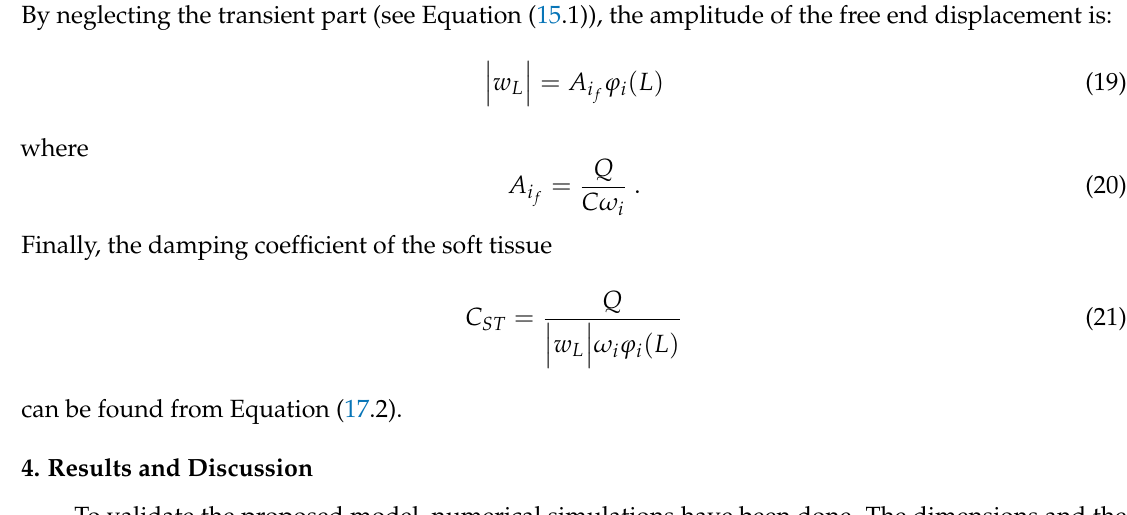
Table 1. Beams, piezoelectric plates and end masses specifications; lengths are expressed in µ m. Material Length Thickness Width Young’s mod. [GPa] Density [ kg / m 3 ] Beams Silicon 750 170 2329 Piezoel. pl. AlN Clamp teeth